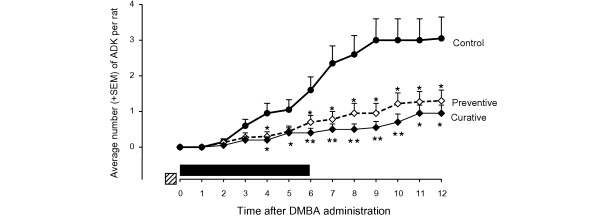
Average number (mean ± standard error of the mean) of mammary adenocarcinomas (ADKs) per rat after daily administration of melatonin (10 mg/kg) for either 15 days before (preventive treatment; open diamonds) or 6 months after (curative treatment; filled diamonds) the administration of dimethylbenz [a]anthracene (DMBA). In both cases, the rats were followed up for 12 months after the administration of DMBA. Hatched bar, duration of preventive treatment; filled bar, duration of curative treatment. *P < 0.05 vs controls; **P < 0.01 vs controls.